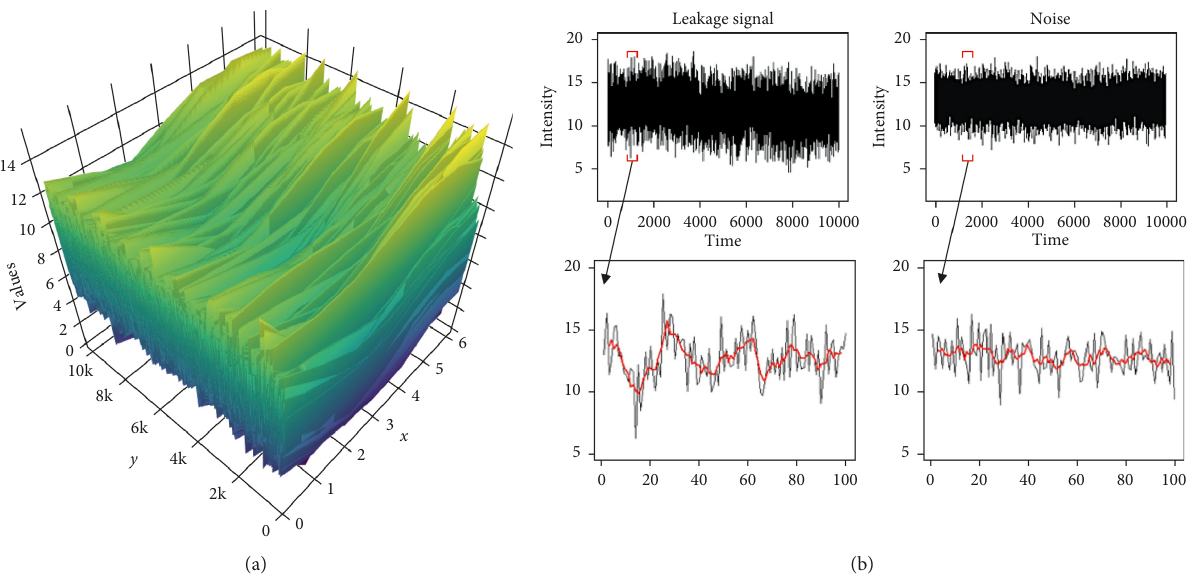
Figure 2: Leakage signals of gas pipelines. (a) 3D leakage signal of gas pipelines. (b) Time-domain characteristics of the leakage signal.